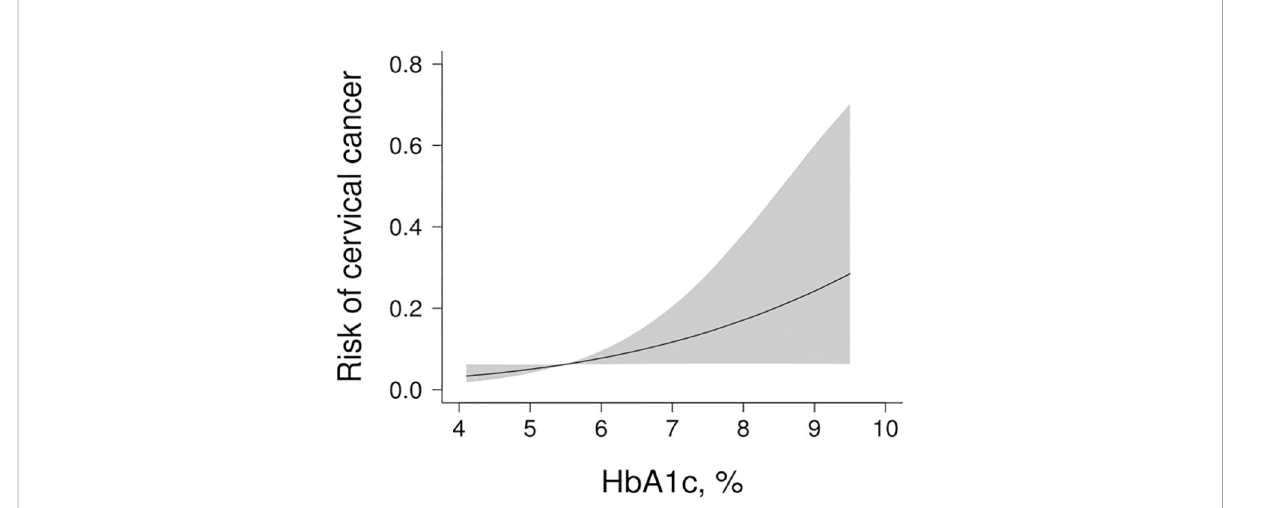
FIGURE 2 The association between HbA1c and cervical cancer. Figure 2 adjusted for age, adverse maternal history, vaginitis, and type of HPV infection. The red line represents the fi tted curve of HbA1c and cervical cancer, and the blue line represents the 95% con fi dence interval of the curve.